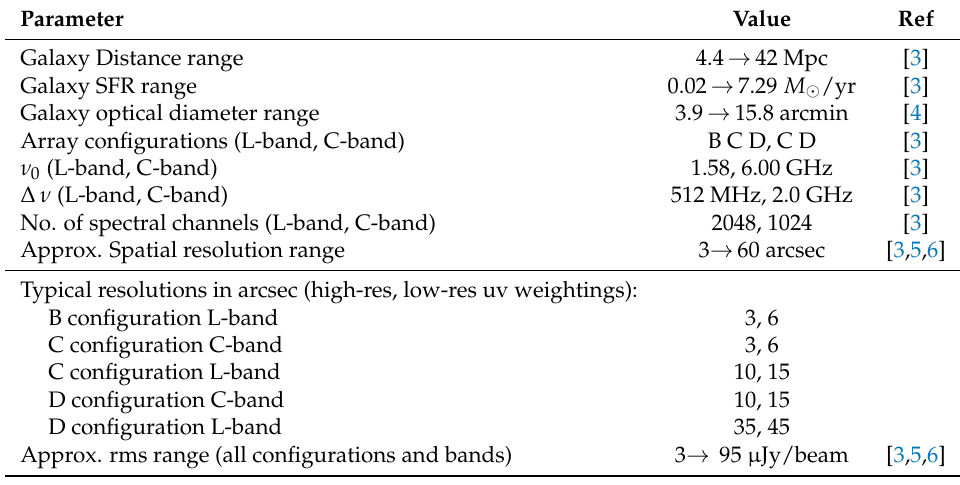
Table 1. Overview of galaxy and observing parameters over frequencies and VLA array configurations. Parameter Value Ref Galaxy Distance